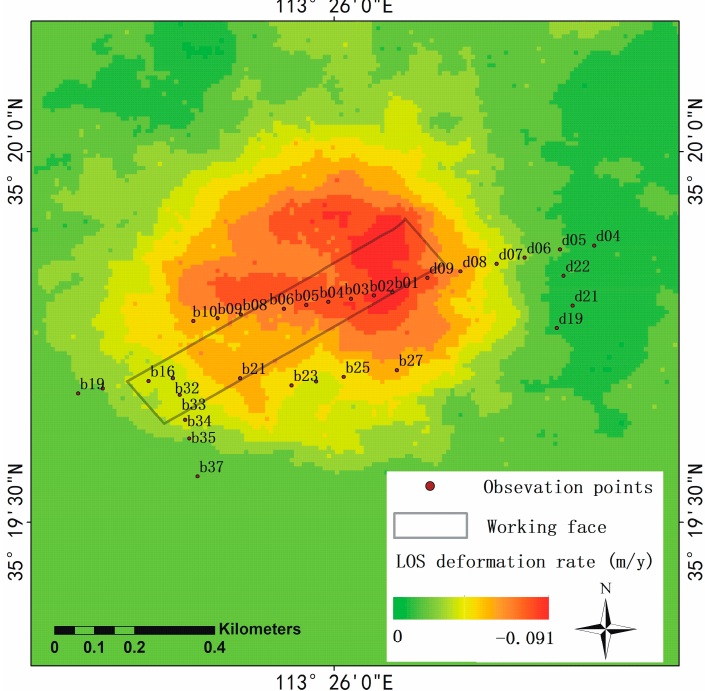
Fig 7 Figure 7. Line-of-sight (LOS) deformation rate processed by SBAS-InSAR. The red zone is the coal mine, and the green zone is the stable zone. The black rectangle is the working face of the coal mine, and the dots are leveling